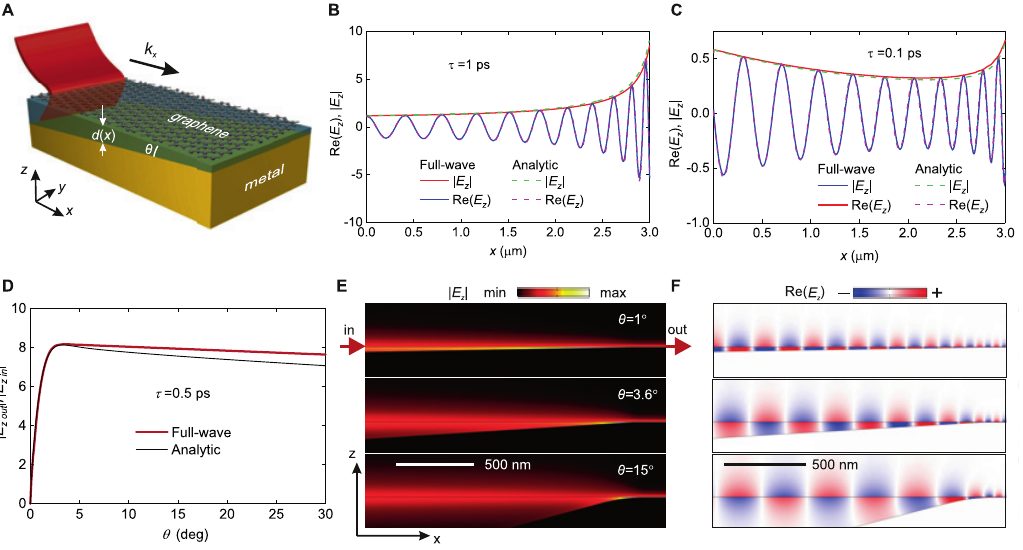
Figure 2: Nanofocusing of AGPs. (A) Schematics of the taper with the propagating AGP. (B, C) vertical field profiles, Re[ E z ( x , z )] and | E z ( x , z )| alongwiththegraphenesheet( z = − 0.5nm)fortwodifferentvaluesof τ .(D)Vertical fi eldenhancement | E z ( x , z ) / E z in | asafunctionof θ .(E)The absolutevalueoftheverticalcomponentoftheAGP fi eld | E z ( x , z )| fordifferentvaluesofthetaperingangle θ considering τ =0.5ps.(F)Sameas (E) for the real part, Re[ E z ( x , z )]. In all panels we assume E F = 0.44 eV and ω = 1000 cm − 1